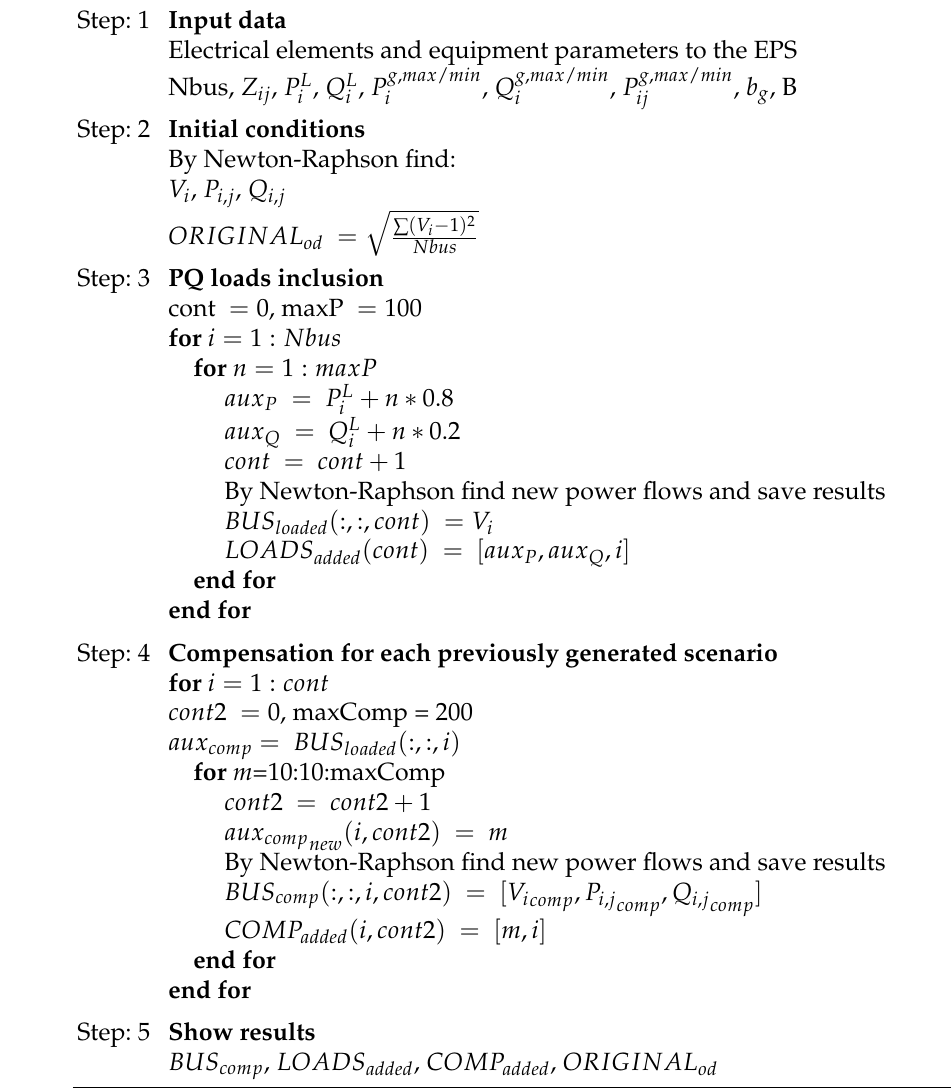
Algorithm 1 Brute force algorithm: load connection and compensation for every possi- ble